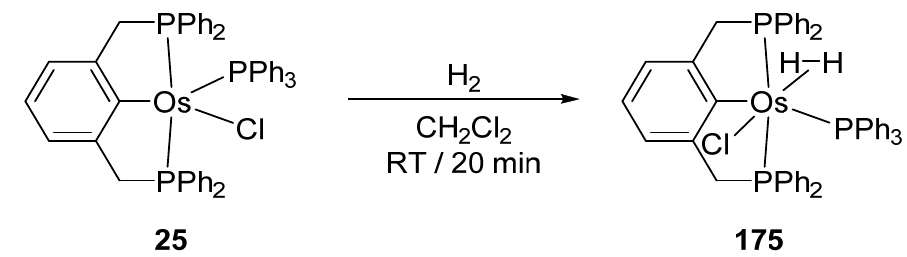
Figure 37. Coordination of dihydrogen to a pincer complex.